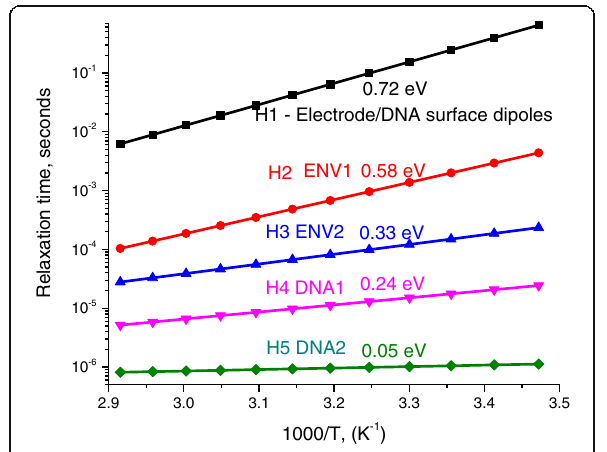
Fig. 18 Relaxation time of electric charges on H1, H2, H3, H4, and H5 as a function of 1000/T ( K − 1 ). The slopes of semilog lines are 0.72, 0.58, 0.33, 0.24, and 0.05 eV for charges on H1, H2, H3, H4, and